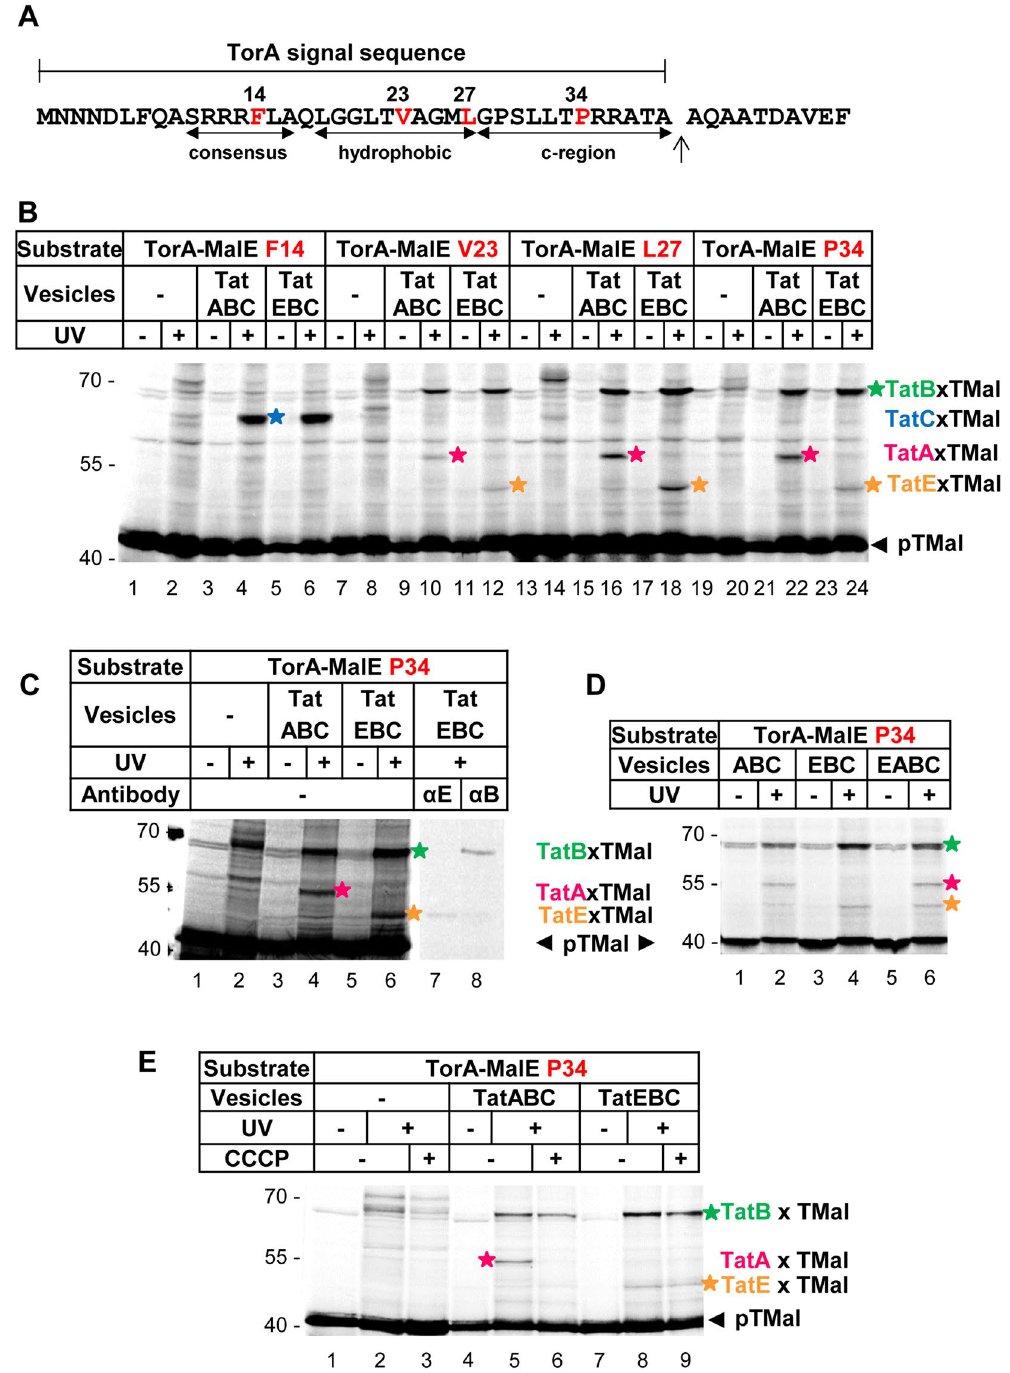
Figure 1. TatE interacts with the signal sequence of a Tat substrate. ( A ) Primary structure of the TorA-signal sequence. The twin-arginine consensus motif, the hydrophobic core and the c-region are indicated. Amino acid residues substituted by the photo-crosslinker p -benzoyl-L-phenylalanine (Bpa) are labeled in red. ( B – E ) The model Tat substrate TorA-MalE335 (TMal) was in vitro synthesized and radioactively labeled. Bpa was incorporated into the signal sequence at the indicated positions (red). After incubation with inverted inner membrane vesicles containing the indicated Tat components, crosslinking was induced by UV-irradiation (UV). The samples were resolved by 10% SDS-PAGE and analyzed by phosphorimaging. Adducts between the substrate and TatC (blue star), TatB (green star), TatA (magenta stars) and TatE (orange stars) are indicated. ( C ) Adducts between TMal, TatE and TatB were confirmed by immuno-precipitation using antisera against TatE and TatB. The eight lanes are derived from a single gel after excising a piece between lanes 6 and 7. ( D ) In vesicles containing TatE alongside TatA, the signal peptide cross-links to both Tat proteins. ( E ) Dissipation of the proton-motive force by 0.1 mM CCCP abolishes contacts with TatA but not with